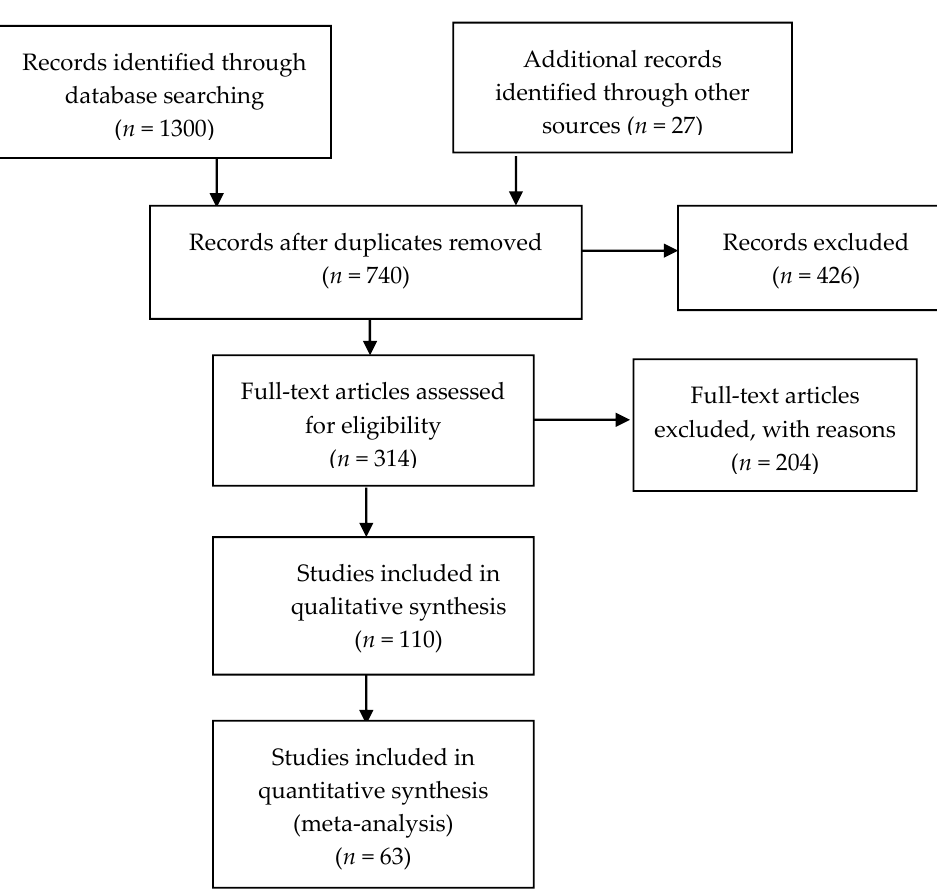
Figure 2. PRISMA flowchart for screening